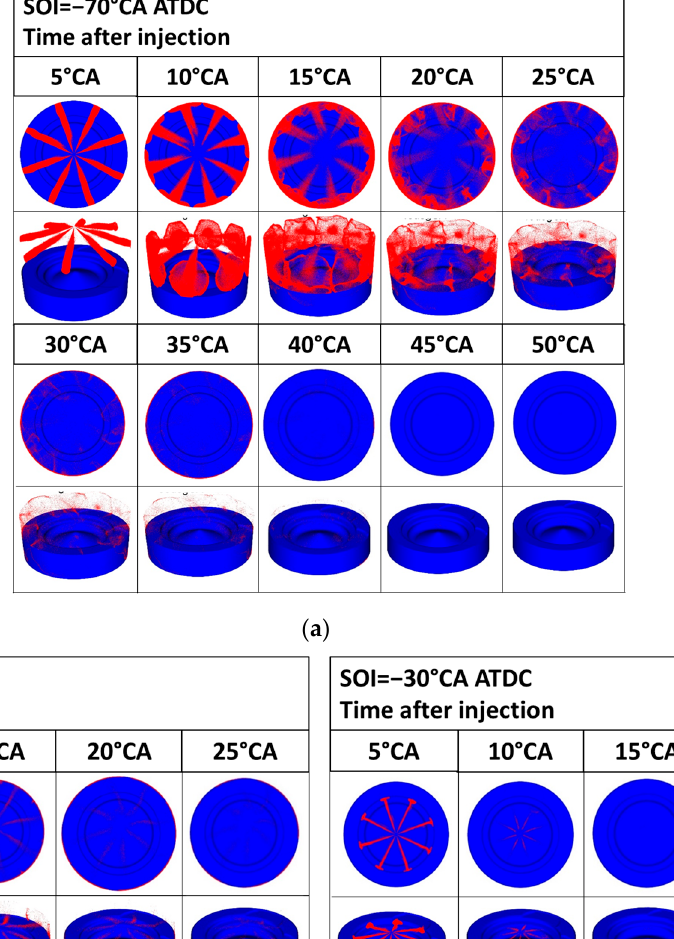
oblique side views are presented in Figure 16.